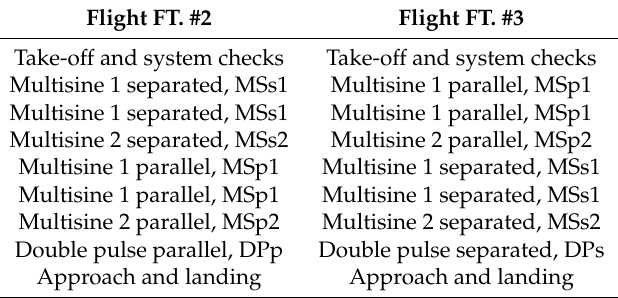
Figure 13. GFF demonstrator on final approach with gear down as seen from external and on-board cameras. Table 3. Test program for